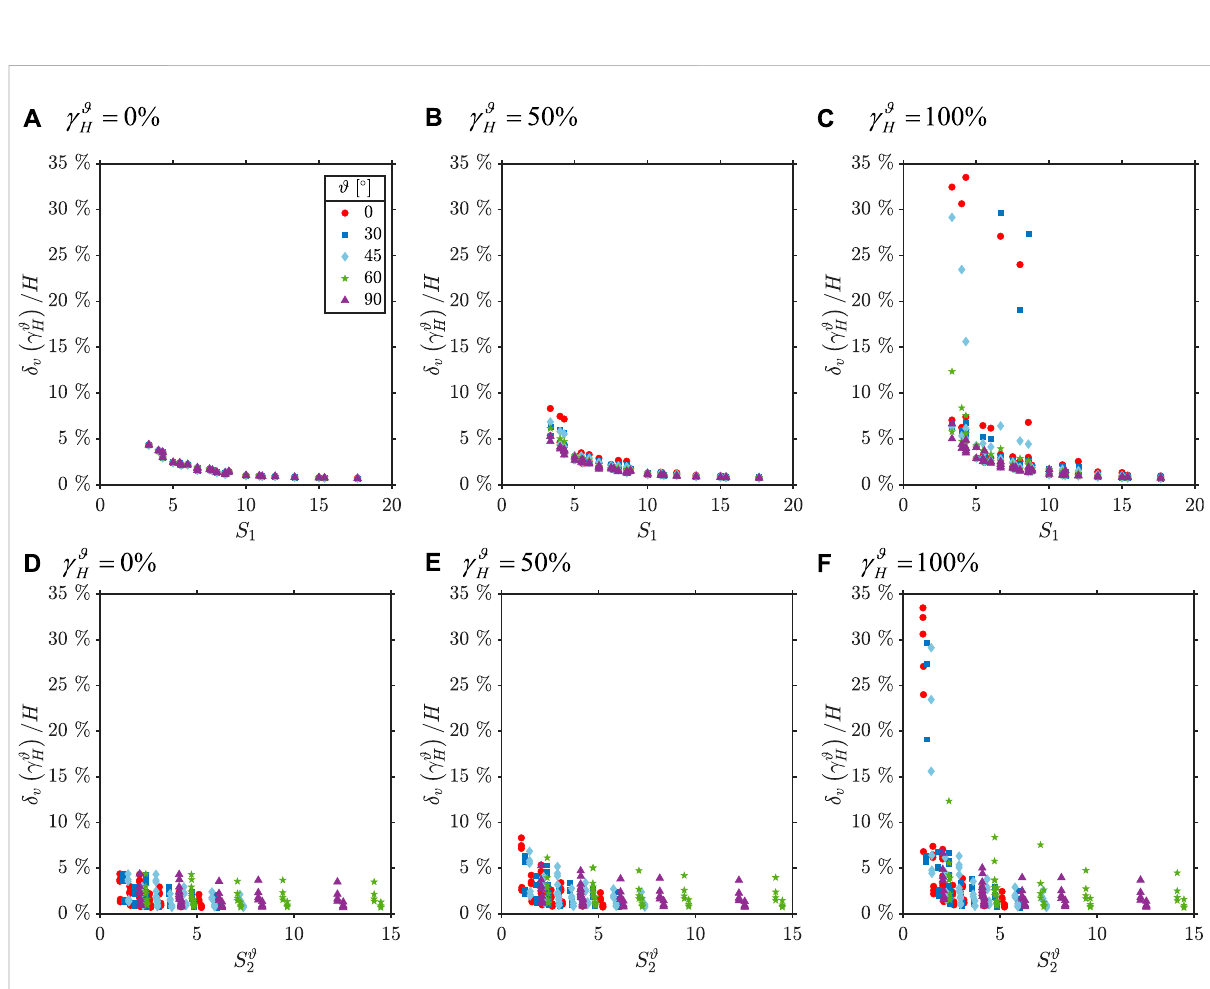
FIGURE 3 Trends of the ratio between vertical displacements and total height with the primary and secondary shape factor.